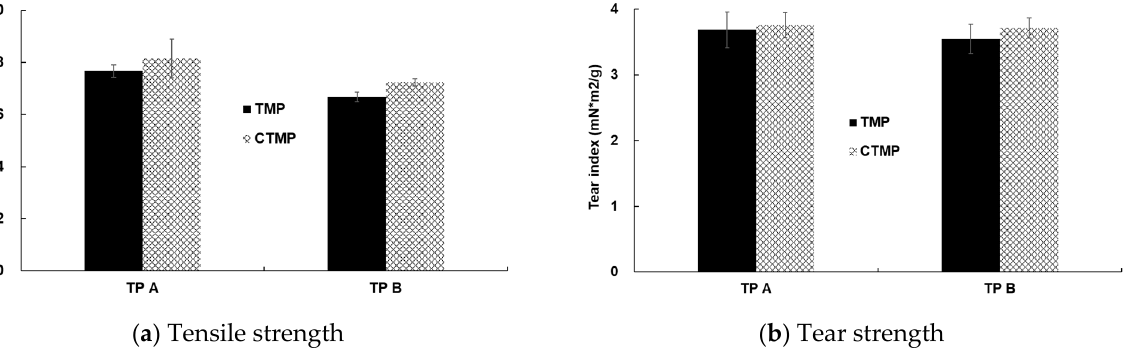
Figure 7. Change in tensile and tear index bulk of TMP and CTMP prepared from the plates with distinctive patterns (tensile strength of TMP and CTMP are significantly different at p ≤ 0.05 according to Tukey(cid:31)s multiple comparison tests).